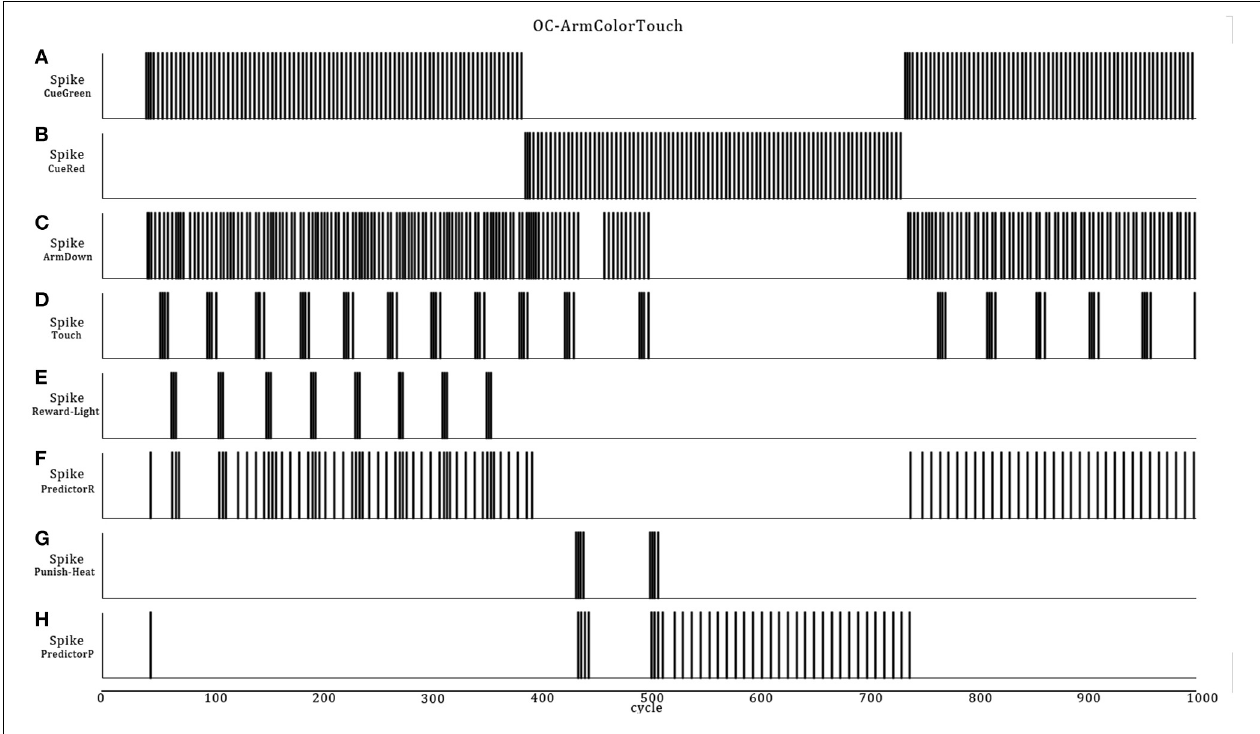
FIGURE 9 | Neural dynamics details of the OC-Arm-Down simulation when the robot passes through the first three zones. The graphic shows the sensory color neurons (A,B) which are the Cues and leads to the Arm-Down behavior (C) , followed by touches on the floor (D) . These actions